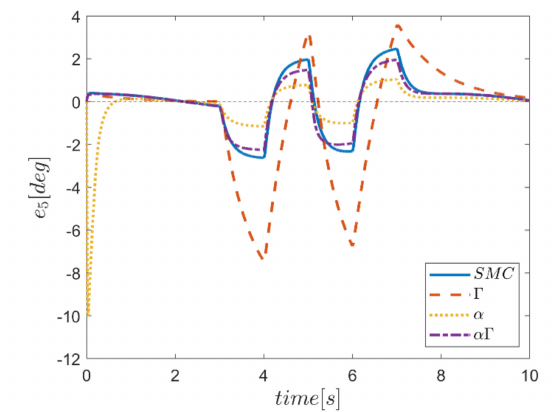
Figure 22. Tracking error in the θ channel.